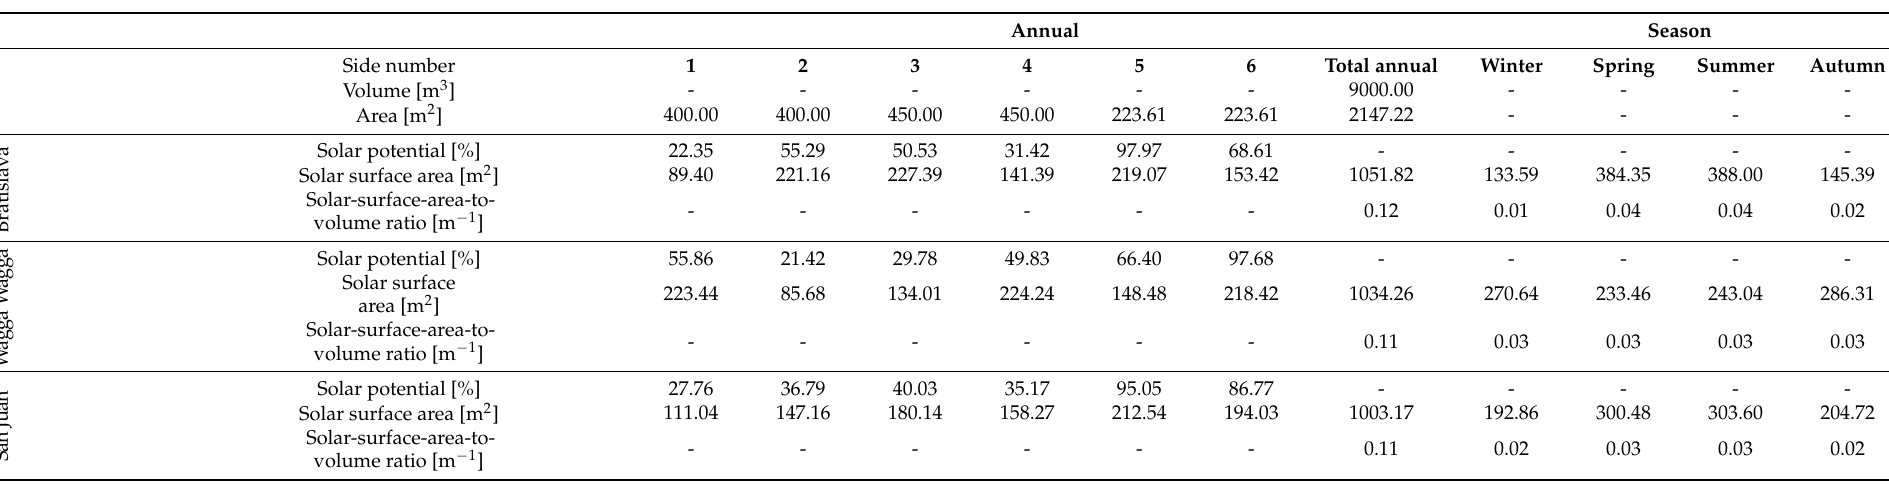
Table 2. Calculated values for Bratislava, Wagga Wagga, and San Juan. Annual values are shown for every side of the house. The seasonal values are only applicable with respect to the entire solar surface area and the solar-surface-area-to-volume ratio of the